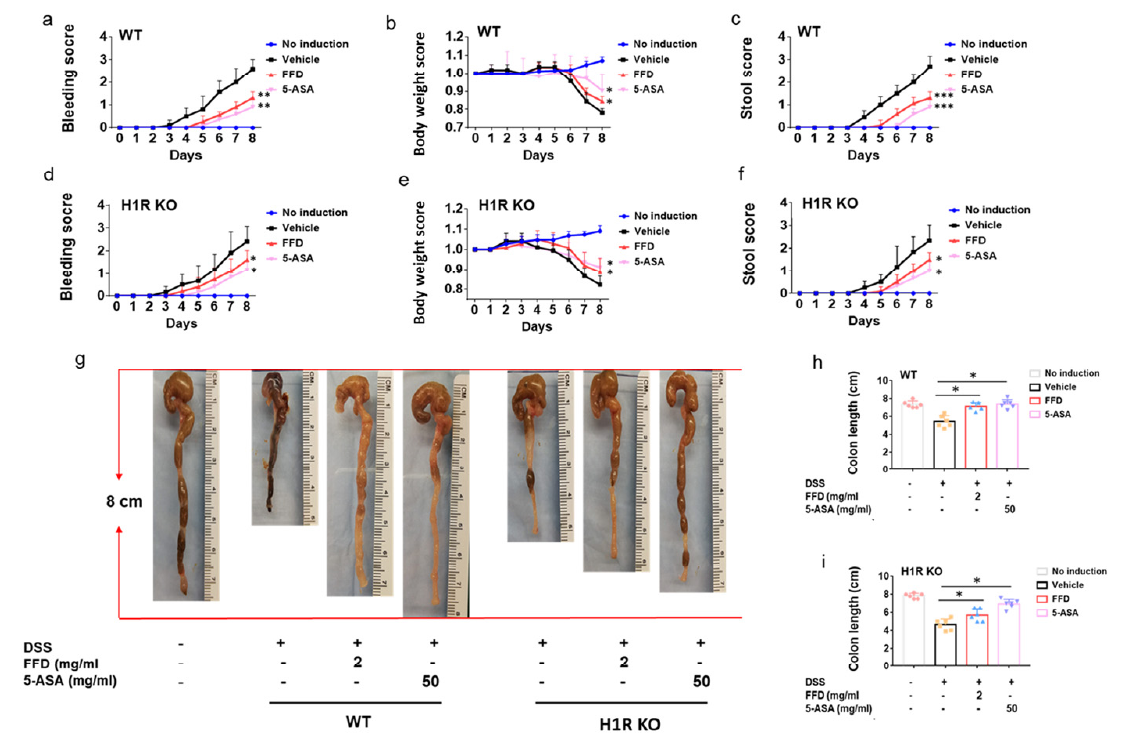
Figure 5. Clinical score of Fexofenadine (FFD)-treated and control groups in DSS-induced H1R knockout mice. ( a – c ) Clinical score of controls and FFD-treated WT groups. ( a ) Bleeding scores of controls and FFD-treated WT groups. ( c ) Body weights of controls and FFD-treated WT groups. ( d ) Stool score of controls and FFD-treated WT groups. ( d – f ) Clinical score of controls and FFD-treated H1R KO groups. ( d ) Bleeding scores of controls and FFD-treated H1R KO groups. ( e ) Body weights of controls and FFD-treated H1R KO groups. ( f ) Stool score of controls and FFD-treated H1R KO groups. ( g – i ) Colon lengths of controls and FFD-treated WT or H1R KO groups and the quantification of colon lengths. Statistical analysis was done to compare the treatment groups and vehicle groups. n = 6 per group. Data are mean ± SE; * p < 0.05, ** p < 0.01, *** p <